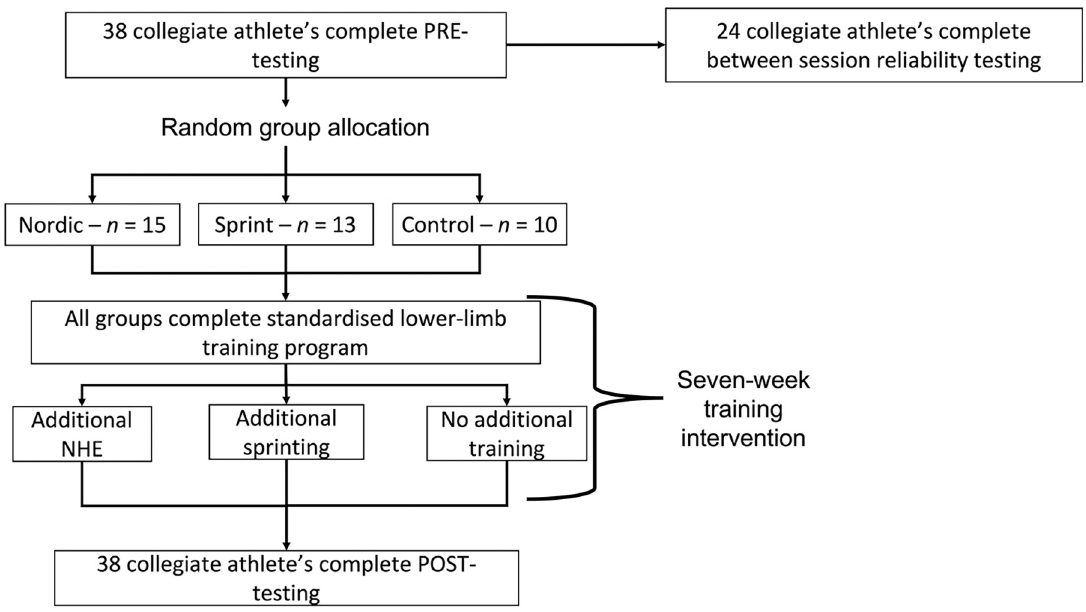
Fig 1. Schematic diagram of pre-testing, seven-week intervention and